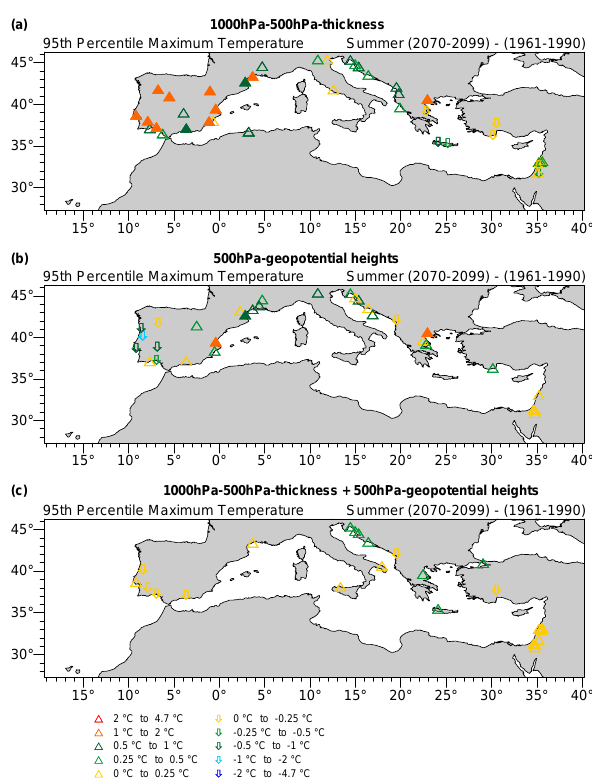
Figure 4: Changes of the 95 th percentile of maximum temperature in summer (June to August) according to statistical downscaling assessments using ECHAM5/MPI-OM predictors under SRESA1B scenario assumptions. Differences of the seasonal extreme indices between the periods 2070-2099 and 1961-1990 in °C. Statistical downscaling technique: Multiple Regression analysis. Colour-filled symbols: signal/noise ratio greater than 1. Figure 4a: Predictor: 1000hPa-500hPa-thickness. Fig. 4b: Predictor: 500hPa-geopotential heights. Fig. 4c: Predictors: 1000hPa-500hPa-thickness and 500hPa-geopotential heights.